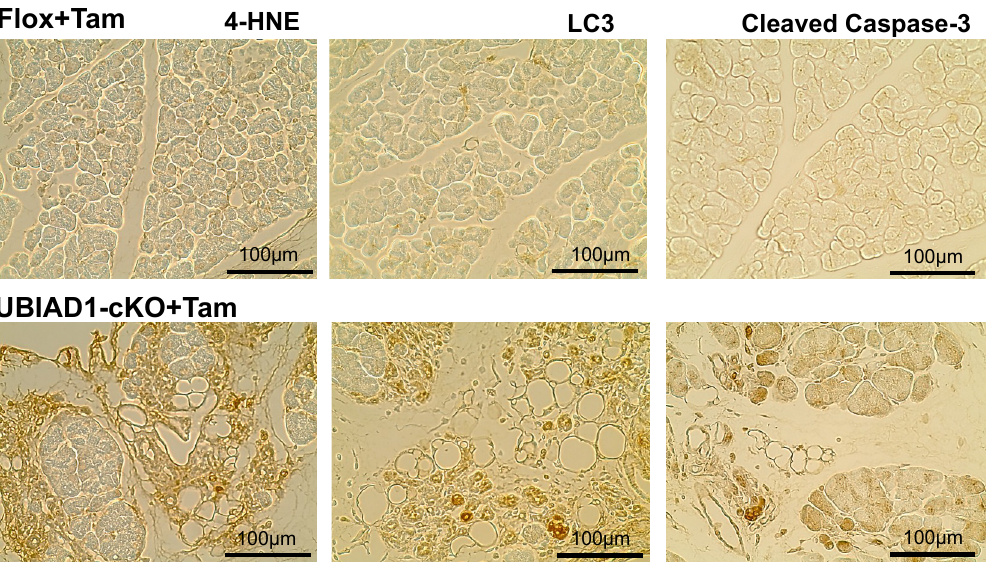
Figure 6 . Expression of oxidative stress, autophagy, and apoptosis-specific markers 4-HNE, LC3, and cleaved caspase-3, respectively, in the pancreas of tamoxifen-treated Flox and UBIAD1-cKO mice at 40 days after administration of tamoxifen.